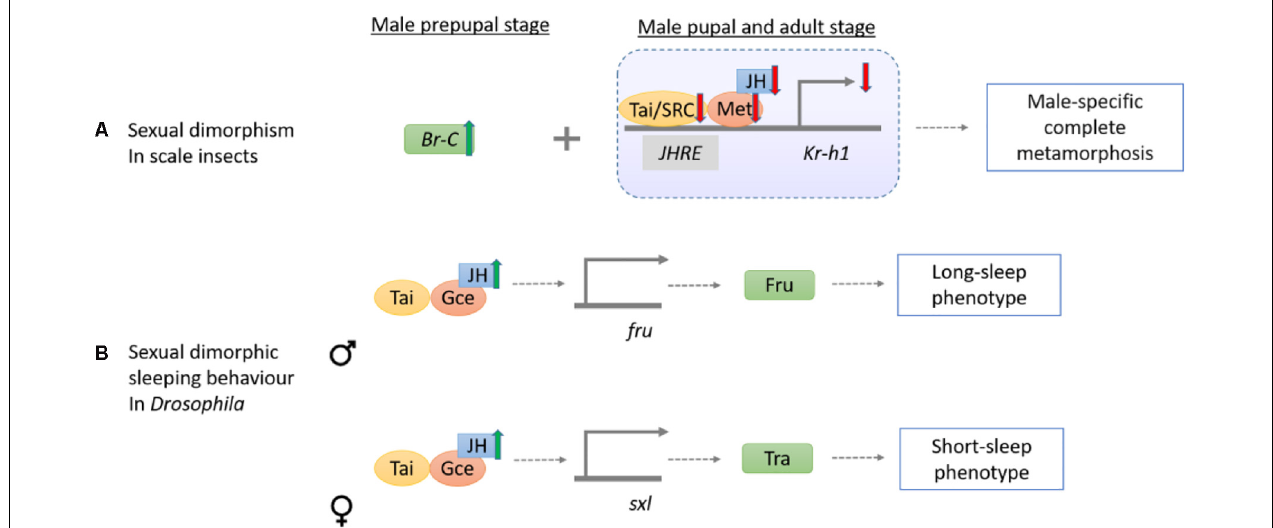
FIGURE 5 | Schematic diagram showing the mechanisms of sesquiterpenoids in regulation of insect sexual dimorphism and dimorphic behavior. (A) In scale insects, sexual dimorphism of winged male adults is linked to the signaling of JH, Met, Tai/SRC, and Kr-h1 , whereas they are increased in early developmental stages but decreased during the pupal and adult stages. (B) The sexual dimorphic sleeping behavior in Drosophila is maintained by the JH-Gce signal on the fru and sxl genes in male and female, respectively. fru then encodes Fru for inducing long-sleep pattern in male while sxl induces Tra for short-sleep phenotype in